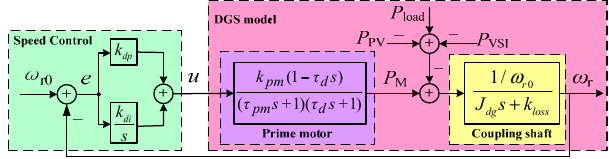
Figure 2. Diesel generator set (DGS) speed control based on a proportional–integrative (PI) controller.